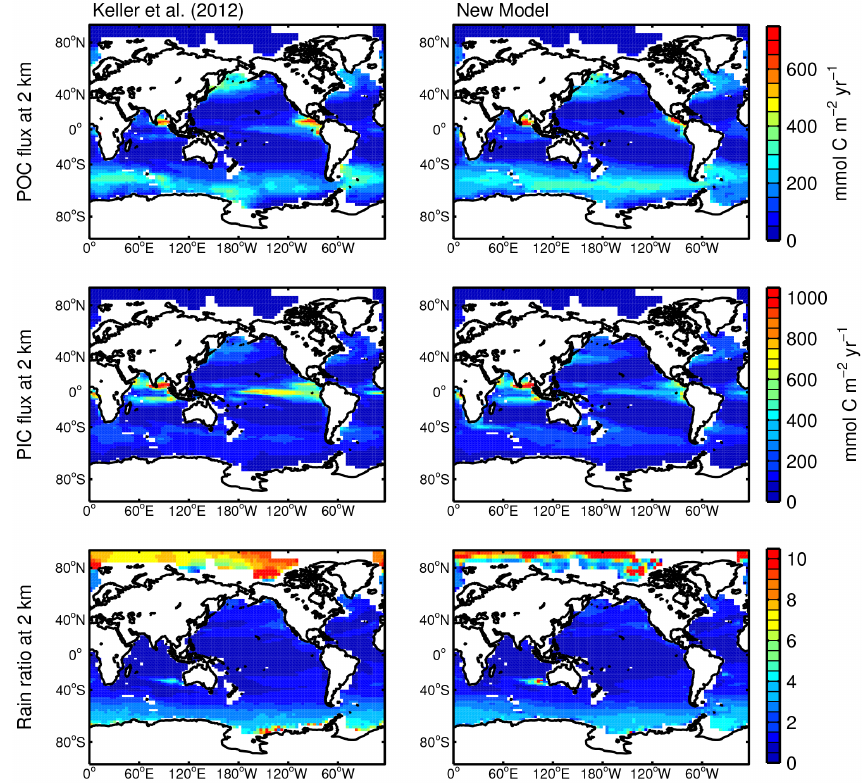
Figure 12. Annual fluxes of POC and PIC at 2km and the rain ratio as simulated with the model by Keller et al. (2012) (left column) and with the new model (right